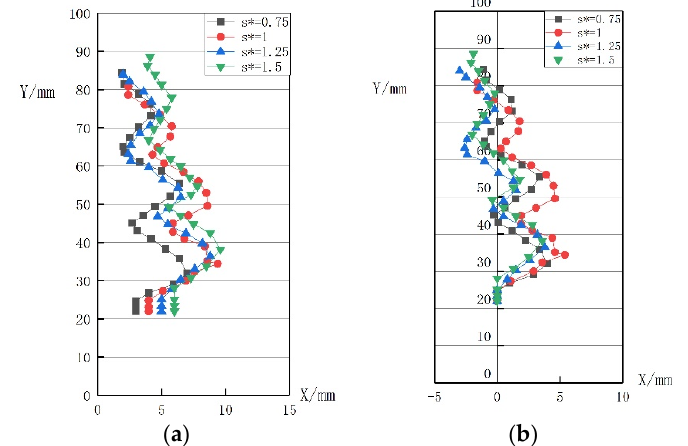
Figure 7. Bubble motion path diagram under different S*: ( a ) Different initial position, ( b ) Same initial position.